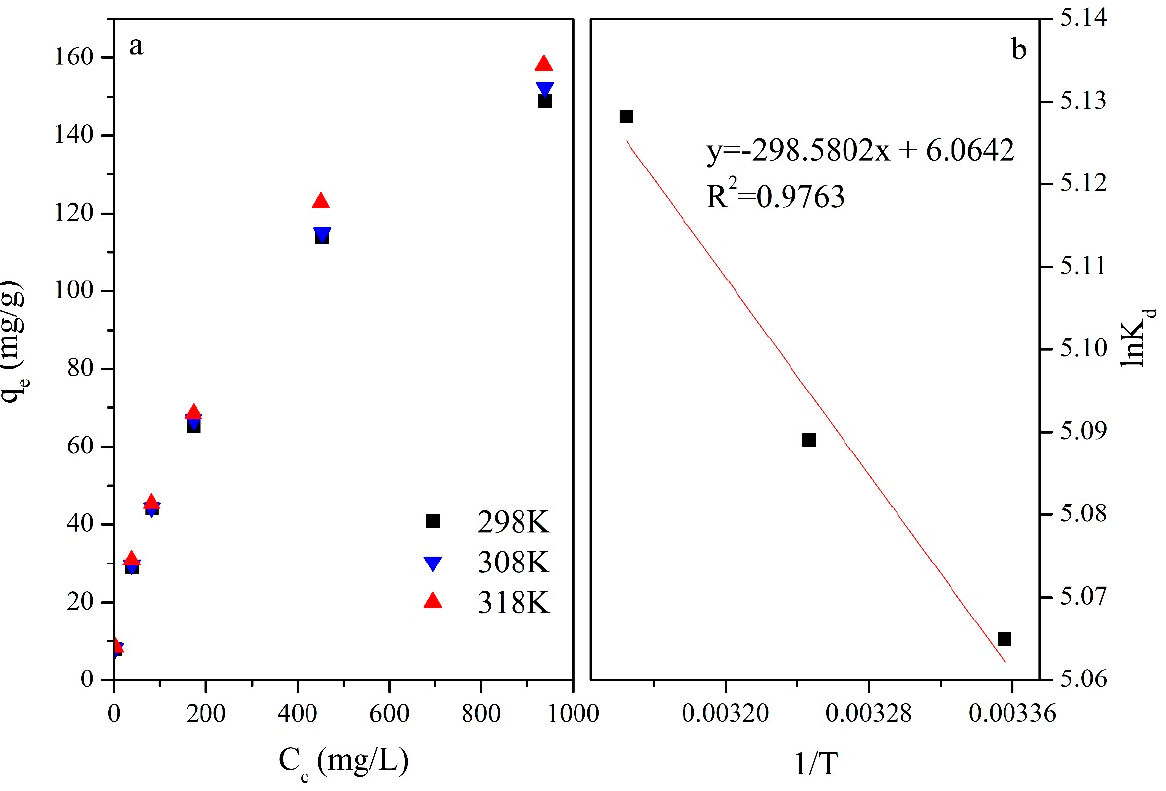
Figure 5. ( a ) Adsorption isotherms of ammonium on M-Zeo under different temperatures; ( b ) plots of lnK d vs. 1/T.